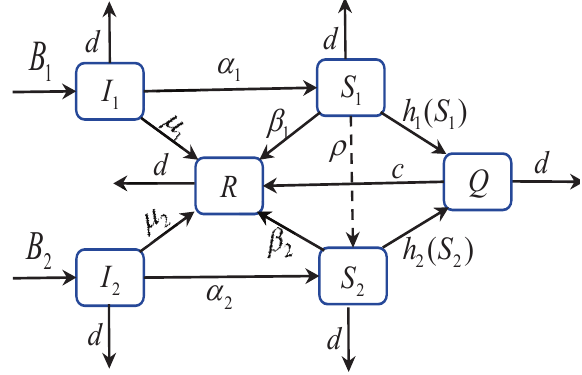
Figure 1. The state transition diagram of 2I2SQR